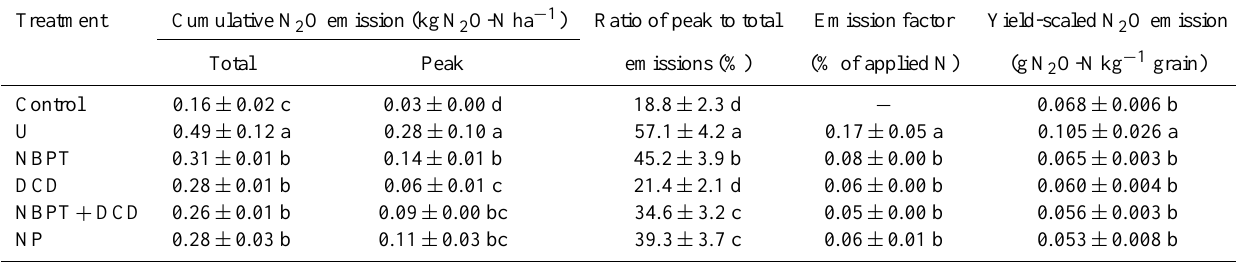
Table 4. Effects of urease and/or nitrification inhibitors and nitrophosphate on cumulative N 2 O emissions, fertilizer N-induced N 2 O emission factors and yield-scaled N 2 O emissions.